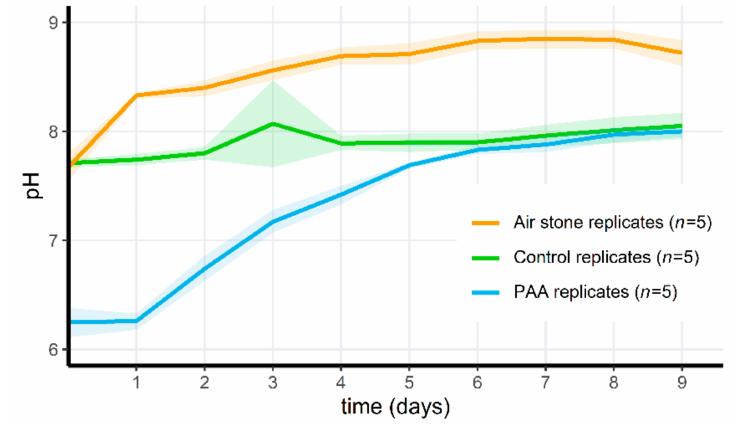
Figure 5. pH changes over time for the PAA-treated microcosms with air stones and PAA treatment (orange), the control microcosms (green) and the PAA-treated microcosms without air stones (blue) during the second microcosm exposure experiment. Shaded areas indicate mean ± standard